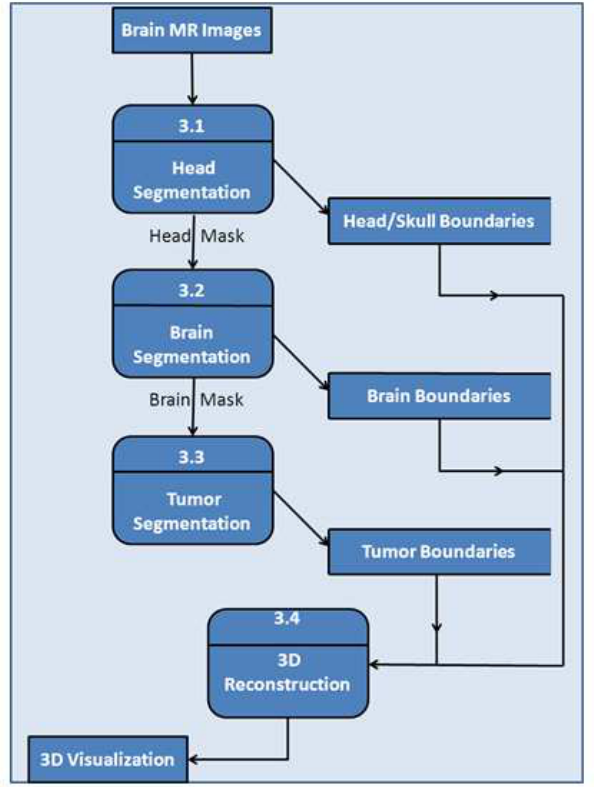
Fig.1 Architecture of the Proposed